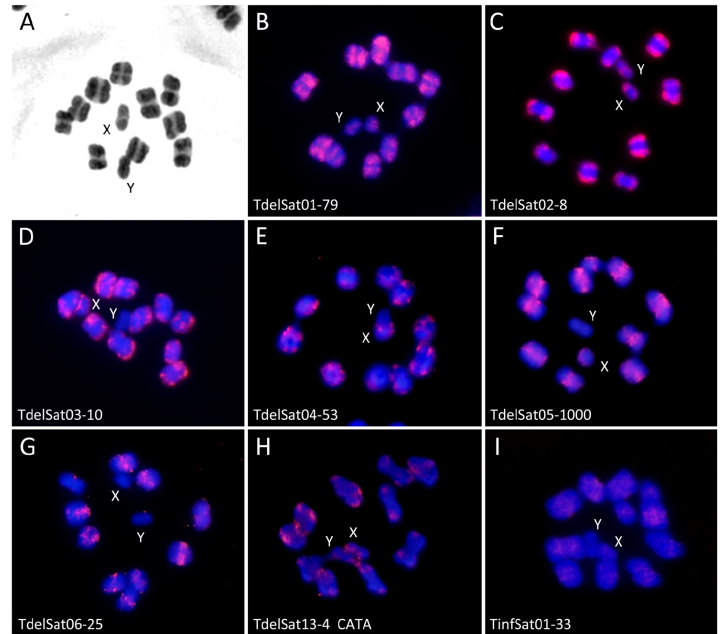
Figure 5. C-banding patterns and satDNA families’ hybridization observed in first meiotic metaphases of T. delpontei . ( A ) C-banding with Giemsa, showing the presence of heterochromatic blocks at one chromosome end of all autosomes and both sex chromosomes. ( B – I ) Meiotic metaphases I after hybridization using different satDNAs as probes: TdelSat01-79 ( B ), TdelSat02-8 ( C ), TdelSat03-10 ( D ), TdelSat04-53 ( E ), TdelSat05-1000 ( F ), TdelSat06-25 ( G ), TdelSat13-4 ( H ) and TinfSat01-33 ( I ).